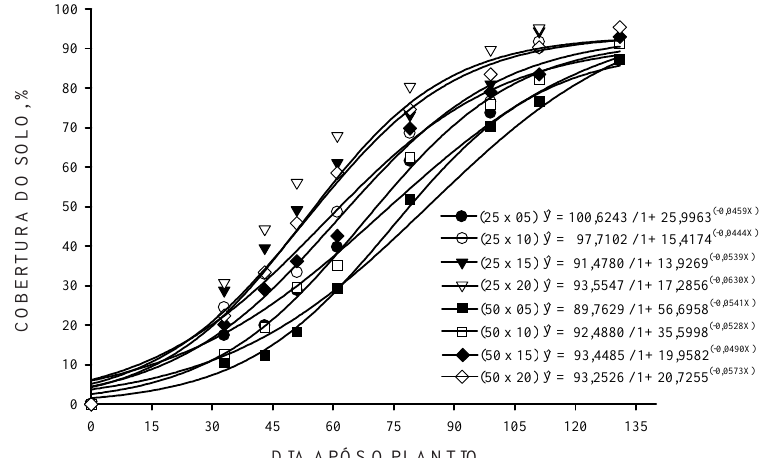
Figura 1. Taxas de cobertura do solo (Y) por galáxia, considerando diferentes espaçamentos e densidades de plantio. Equações significativas a 1% pelo teste F, com R 2 = 0,99.